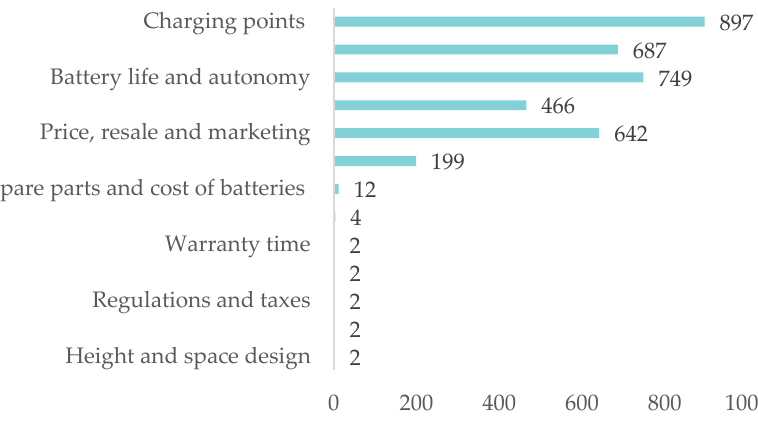
Figure 8. Reasons that concern users before purchasing an EV. According to the citizens surveyed, the most convenient place to recharge if owning an EV is at home. There is also a high number of citizens who prefer to recharge their EVs at public charging points through charging stations (see Figure